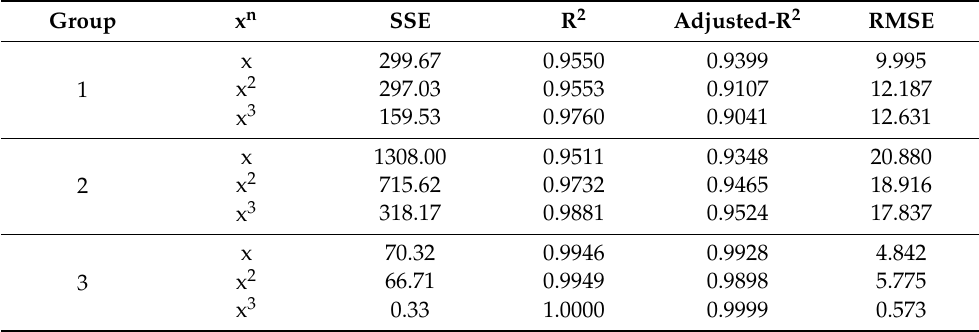
Table 1. Fitting results of different indices of x in the coronal plane.